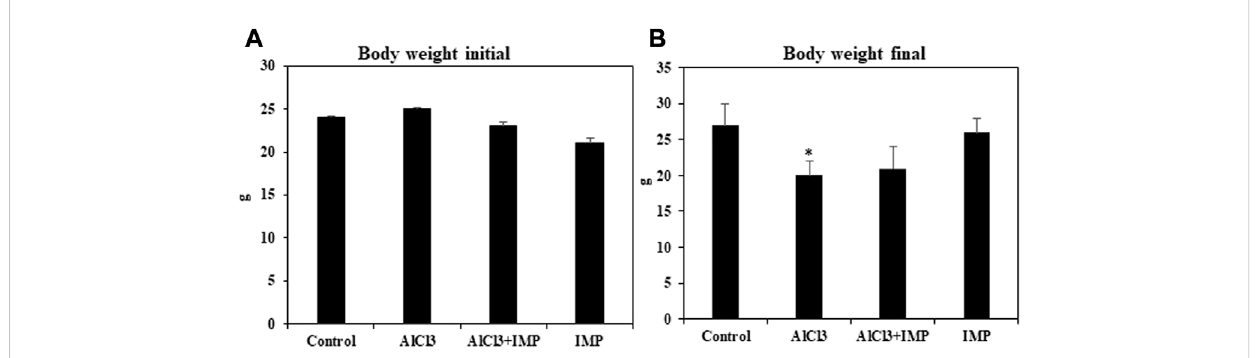
FIGURE 1 Effect of IMP on body and brain weight of experimental animals. (A) Body weight of animal starting date (g). (B) Body weight of the animal at theend of experimental date (g). The difference between the treatment and control groups was statistically signi fi cant; * p < 0.05, # p < 0.05 was considered statisticallysigni fi cant.Valuesareexpressedasmean±SD, n =3.* p < 0.05indicatessigni fi cantdifferencesbetweentheAlCl3alonegroupandthecontrol group. # p < 0.05 shows signi fi cant differences between AlCl3 alone and IMP with